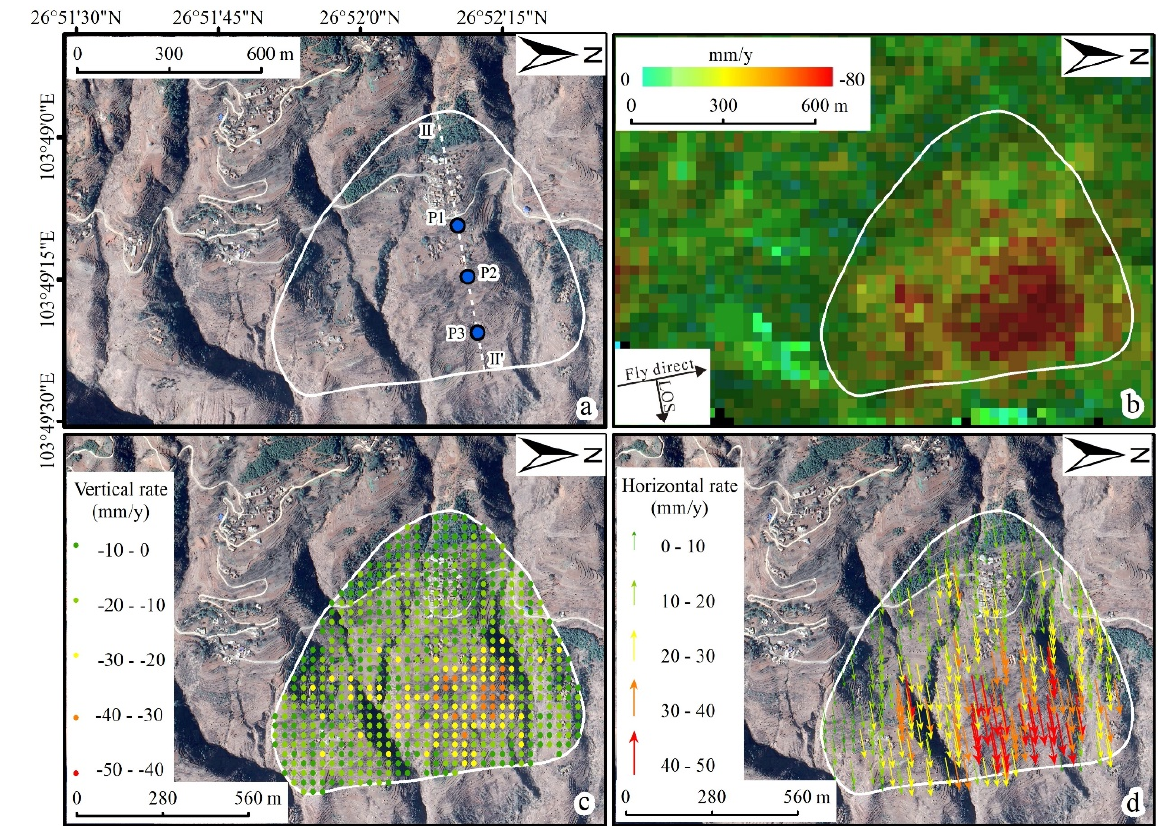
Figure 10. ( a ) Overview of HJP landslide; ( b ) annual average displacement in LOS direction obtained from Sentinel-1 descending images; ( c ) vertical rate; ( d ) horizontal rate.